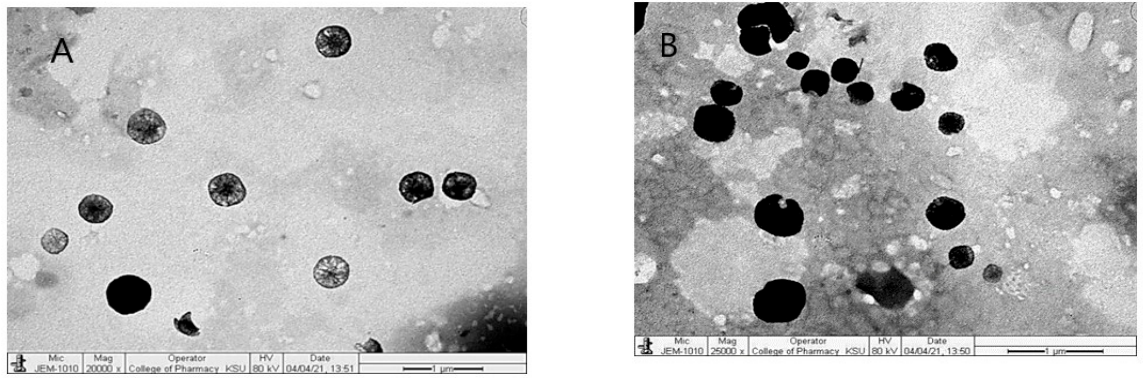
Figure 1. Transmission electron microscope (TEM) images of GLP-CS-DL1 ( A ) and GLP-CS-DL3 ( B ).